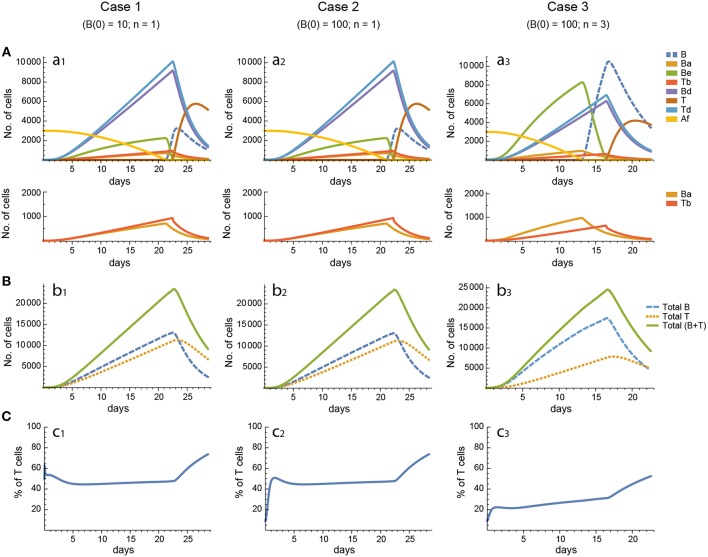
Reference dynamics of model 1. (A) Dynamics of individual compartments. The second row shows in detail the kinetics of those variables reaching low values. (B) Global dynamics. The dynamics of total B cells (BT), total T cells (TT), and total lymphocytes (BT + TT) are shown. (C) Percent of total T cells out of total lymphocytes. Parameter values used: δ = 0.99; c1 = 17.33 day−1(molec/GC)−1; c2 = 16.18 day−1(cell/GC)−1; p1 = 1.97 day−1; db = 2.68 day−1; a1 = 33.11 day−1; a2 = 19.92 day−1; p2 = 1.78 day−1; dt = 0.22 day−1; Kb = 8285.60 cell/GC; Kt = 383.98 cell/GC.